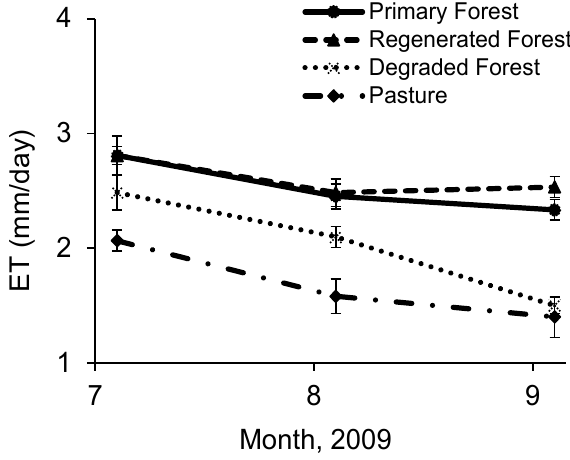
Figure 10. Dry season ET from the three different forest categories and pasture in Mato Grosso.